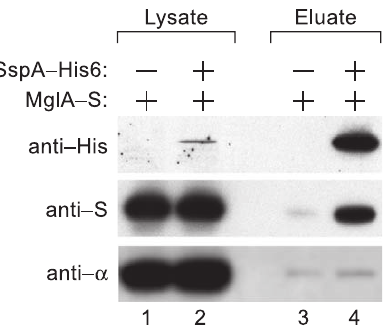
Figure 3. MglA Co-Purifies with His-Tagged SspA Immunoblot analyses of proteins co-purifying with SspA-His6. Cell lysates of E. coli containing MglA-S and SspA (i.e., without the His-tag) or MglA-S and SspA-His6 were incubated with a metal chelate affinity resin. Following washing, proteins specifically bound to the resin were eluted with imidazole. Cell lysates and eluted proteins were separated on a 4%– 12% Bis-Tris NuPAGE gel and analyzed by immunoblotting using antibodies that recognize the His-tag on SspA-His6 (anti-His; upper panel), the S-tag on MglA-S (anti-S; middle panel), and the a subunit of E. coli RNAP (anti- a ; lower panel). Lane 1, lysate containing MglA-S and SspA. Lane 2, lysate containing MglA-S and SspA-His6. Lane 3, proteins purified from the lysate containing MglA-S and SspA. Lane 4, proteins purified from the lysate containing MglA-S and